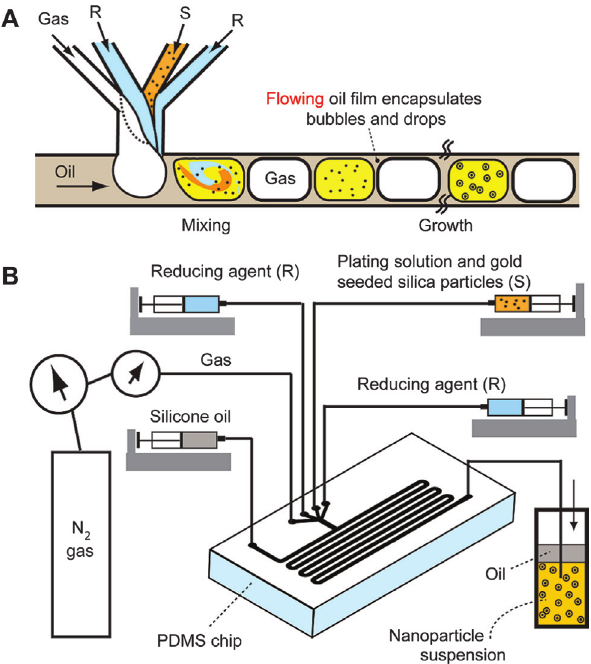
Figure 5 Micro-flow-through arrangement for the synthesis of gold- seeded silica and silica/gold core/shell